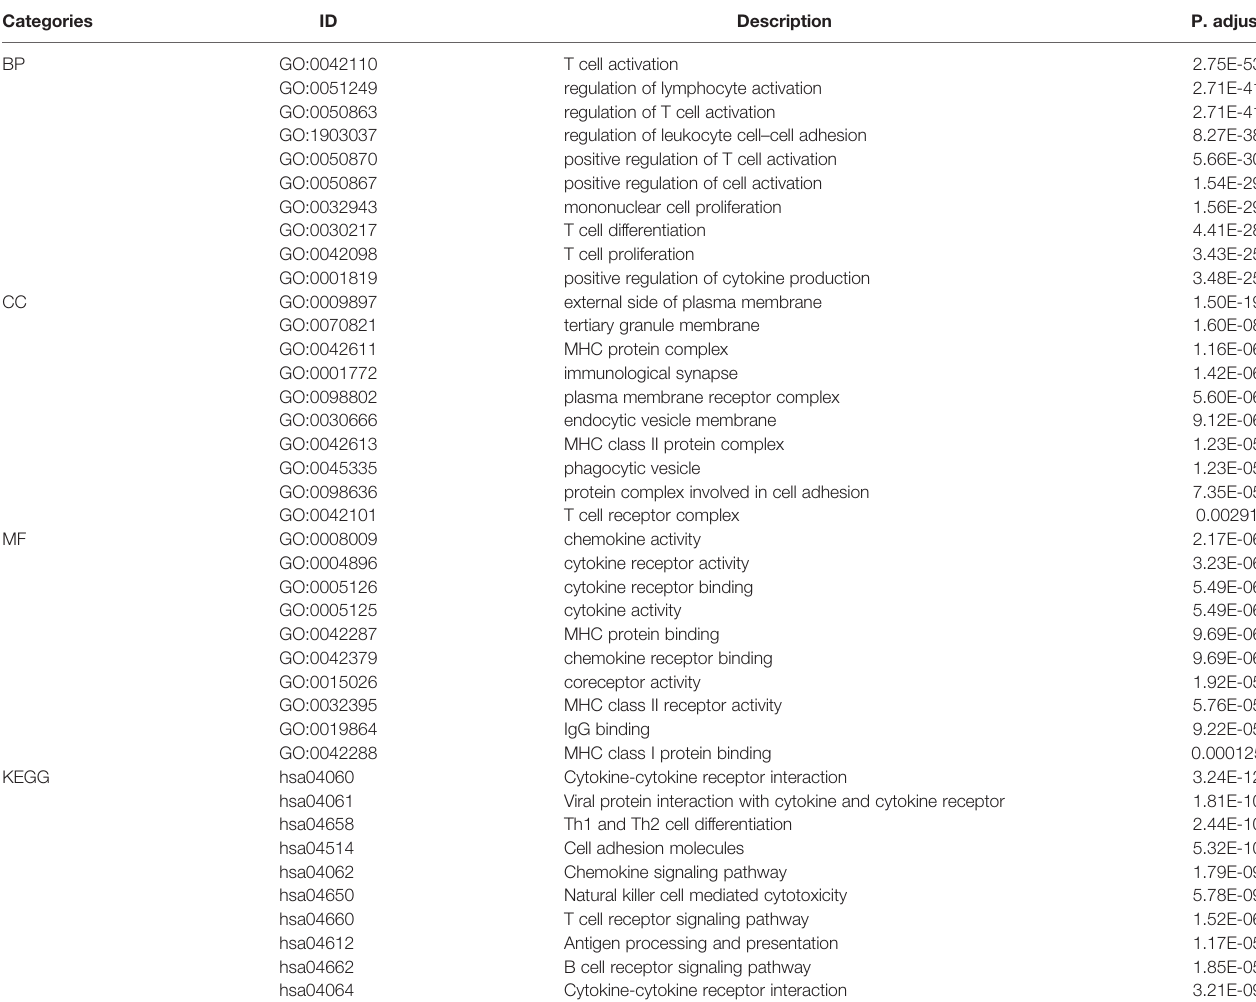
TABLE 4 | GO and KEGG pathway enrichment analysis of radiomic-related genes. Categories ID